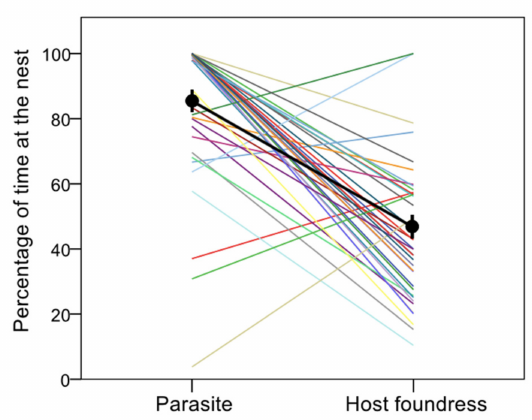
Figure 3. Percentage of time parasites and hosts spent at the nest. Each line links the values for the parasite (left) and her host foundress (right) living at the same colony (pairwise data); the black thick line links the mean values ( ± s.e.) for parasites and foundresses (after averaging by colony). Intriguingly, when they were at the nest, parasites spent proportionally less time than their host foundresses resting at the sunny front face of the nest than at the shadowy back face ([parasite]: β = − 2.554 ± 0.880, χ 2 = 8.425, df = 1, p = 0.004) (Figure